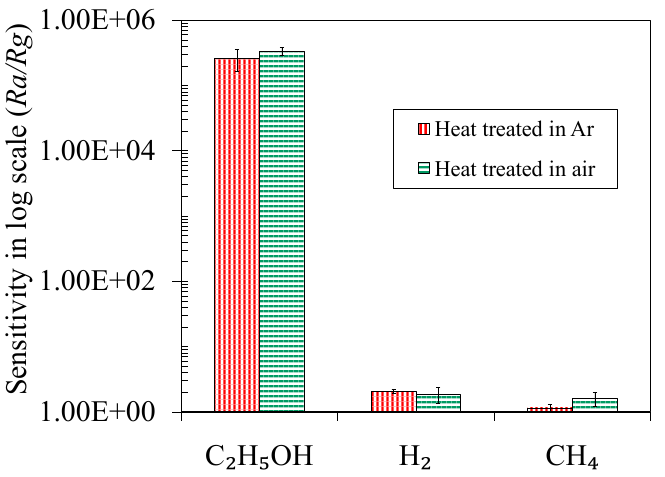
Figure 8. Response of the sensors towards 1000 ppm C heat treating in Ar and air environment at 750 °C for 3